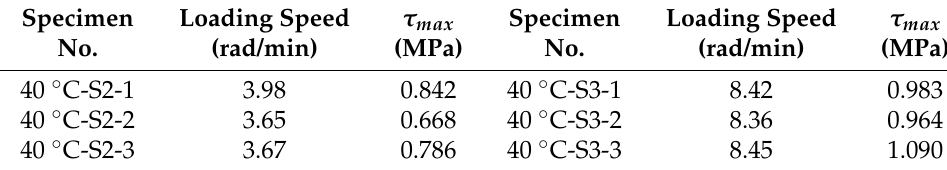
Figure 9. Time dependency of shear stress at three loading speeds. Table 4. The maximum shear stress of various specimens at different loading